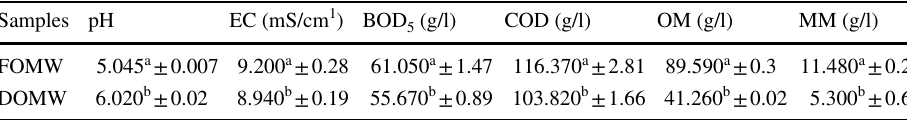
Table 1 Physico-chemical properties of FOMW and DOMW Test Student was determined with FOMW and DOMW ( p = 0.01, * p < 0.05). Mean scores in the same col- umn with different letter (“a” and “b”) are significantly different (for p < 0.05) (Results are compared for the same parameters and the two different